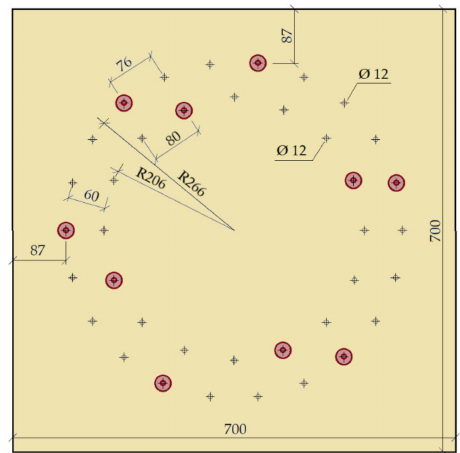
Figure 2. Location of fasteners, bolts, and pins (experiment setup no.